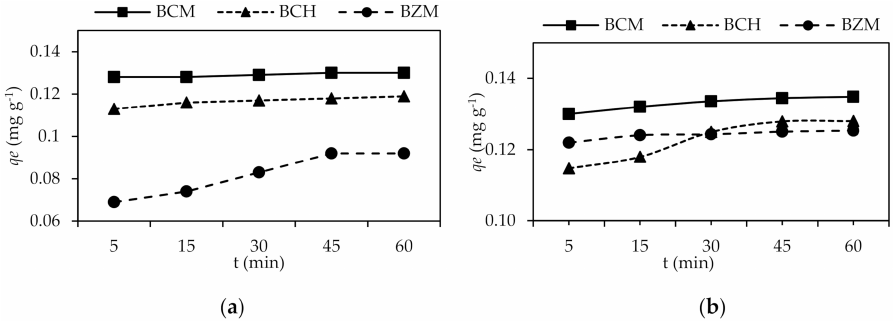
Figure 5. Biochar adsorption kinetics: ( a ) Pb 2 + and ( b ) Cd 2 +